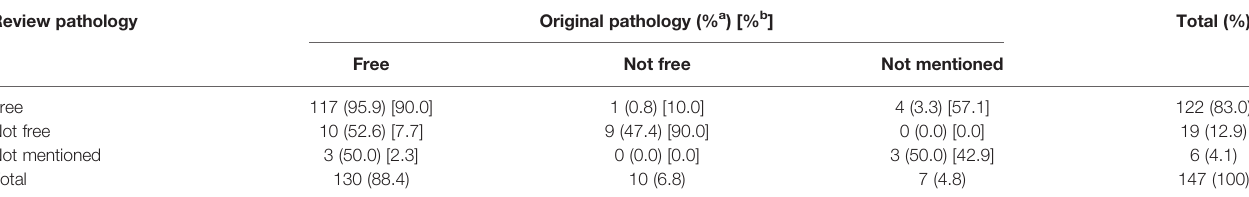
TABLE 5 | Interobserver variation for surgical margin status.